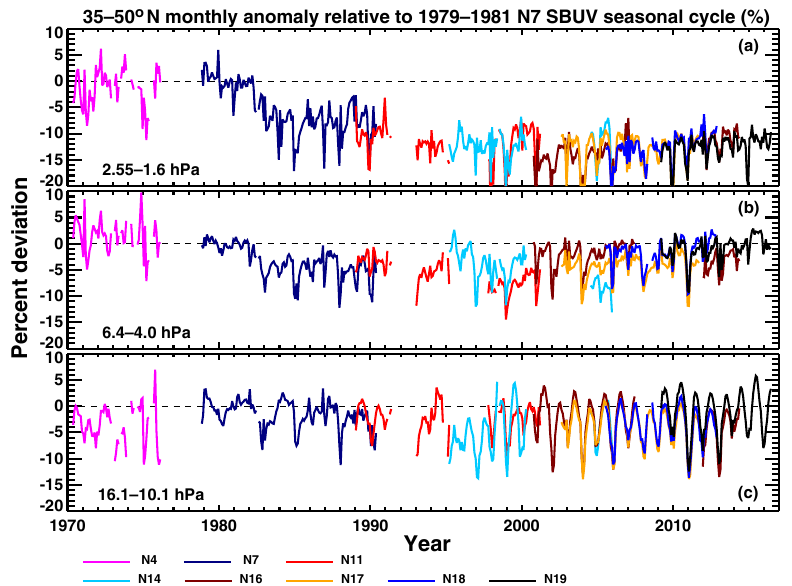
Figure 4. Time series of ozone anomalies from individual SBUV records for three pressure levels. Anomalies are calculated from the 3- year 1979–1981 Nimbus 7 SBUV seasonal cycle. Data are averaged over the 35–50 ◦ N latitude band for (a) 2.5–1.6hPa, (b) 6.4–4hPa and (c) 16.1–10.1hPa. The colors indicate the individual instrument records as indicated at the bottom of the figure.